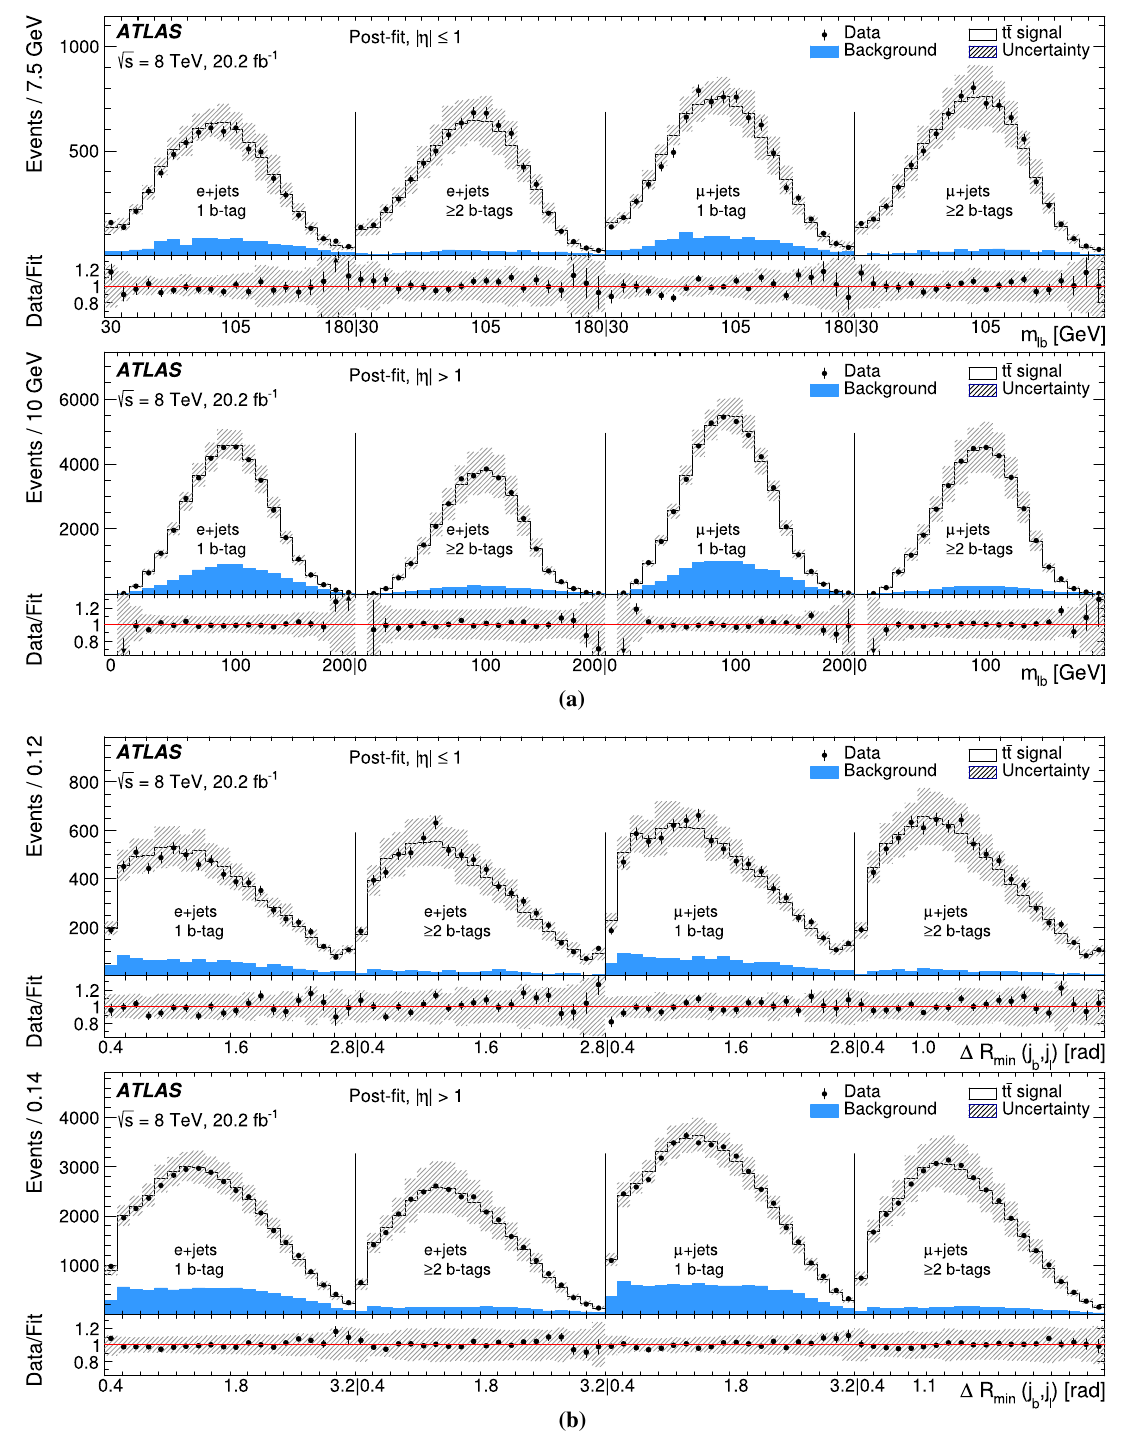
Fig. 5 Post-fit distributions based on the best-fit templates for a m (cid:6) b and b (cid:7) R min ( j b , j l ) . The background contributions are combined. The lower panel shows the ratio of data to post-fit sum of t ¯ t signal and background. The eight analysis regions corresponding to different b - tag multiplicity and jet pseudorapidity are shown. The vertical lines show the boundaries between the binned variables in different lepton